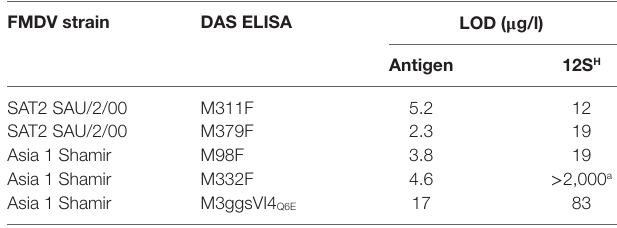
Table 3 | LOD of different DAS